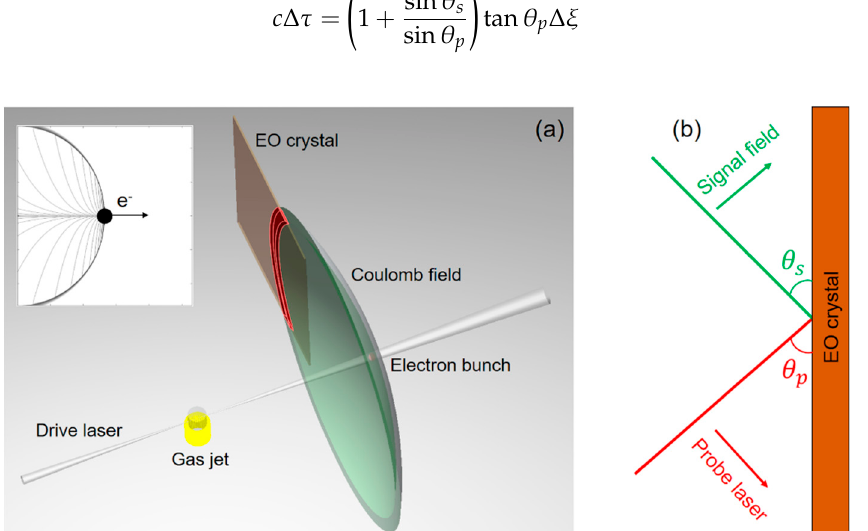
Figure 2. EO spatial decoding set-up in LWFA. ( a ) A geometric schematic showing the relative position of the gas target, driver laser, electron bunch, EO crystal, and the Coulomb field with a spherical front. The inset in ( a ) is a numerical calculation of the Coulomb field lines when an electron passes through a plasma–vacuum boundary. ( b ) A simple sketch showing the oblique incidence of the Coulomb field on the crystal. The signal field front is denoted with a green line and the probe laser front is denoted as red line.